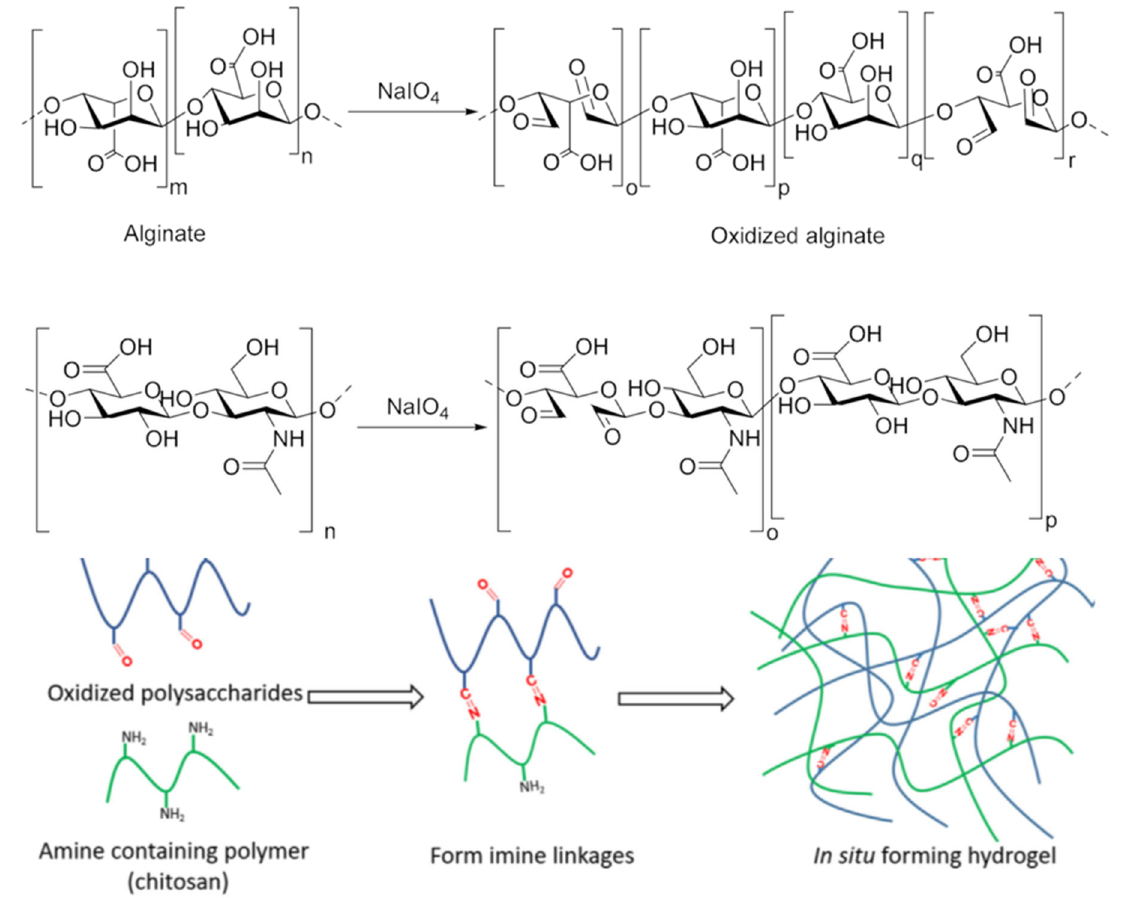
Figure 2. Periodate oxidation of polysaccharides exemplified on two of the most representative examples, i.e., alginate and hyaluronic acid [46], and a typical representation of an in-situ forming hydrogel via Schiff base reaction.